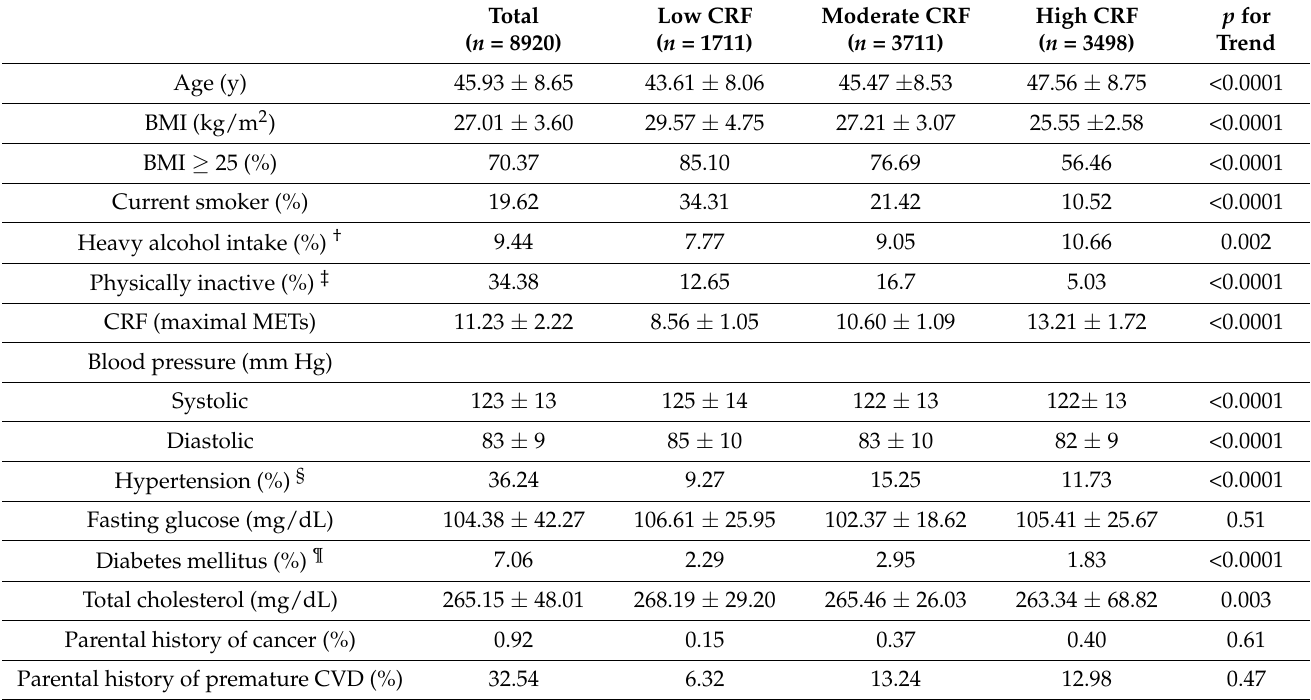
Table 1. Baseline characteristics of study participants by CRF category among men with hypercholes- terolemia